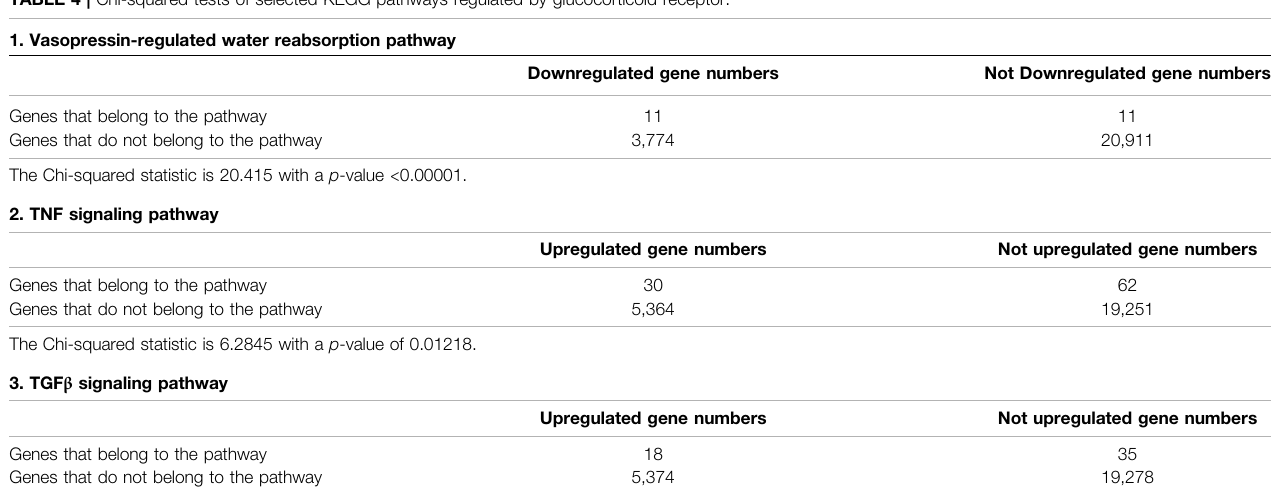
TABLE 4 | Chi-squared tests of selected KEGG pathways regulated by glucocorticoid